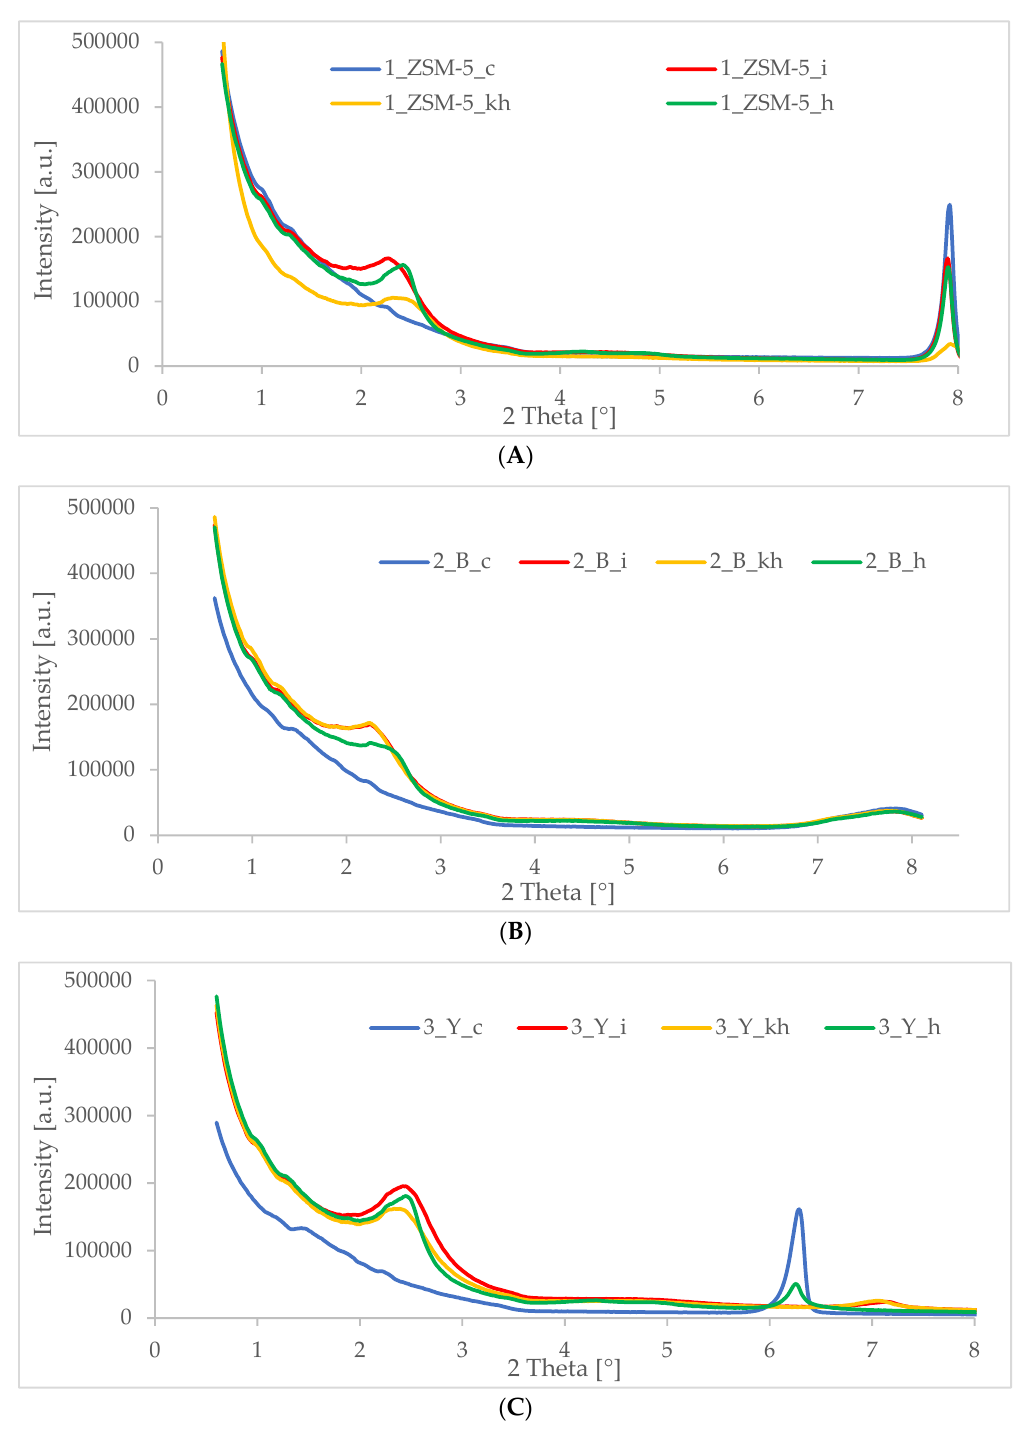
Figure 2. Diffractograms in low-angle range of hierarchical materials: ( A ) based on commercial zeolite of ZSM-5 type (1_ZSM-5_c—commercial zeolite, 1_ZSM-5_i—inulin modified material, 1- ZSM-5_kh—hyaluronic acid modified material, 1_ZSM-5_h—heparin modified material); ( B ) based on commercial zeolite of BEA type (2_B_c—commercial zeolite, 2_B_i—inulin modified material, 2_B_kh—hyaluronic acid modified material, 2_B_h—heparin modified material); ( C ) based on commercial zeolite of FAU type (3_Y_c —commercial zeolite , 3_Y_i —inulin modified